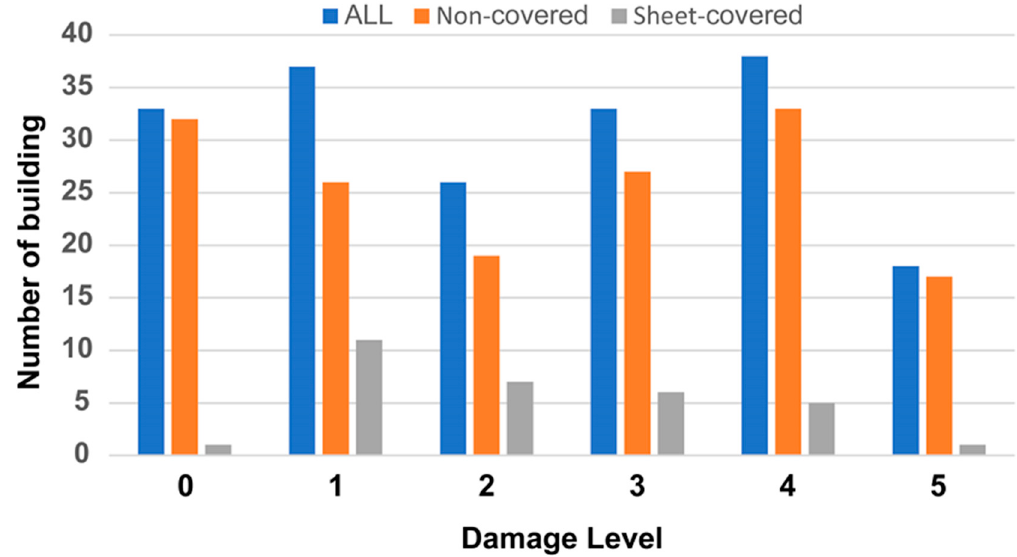
Figure 9. Numbers of all, sheet-covered, and non-covered buildings in each damage level in the buildings inventoried in Mashikimachi.